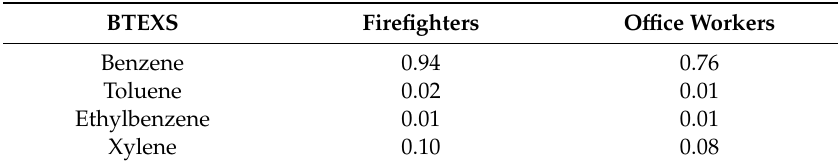
Table 5. Non-cancer risk assessment results for exposure to BTEXS for various groups of fire service